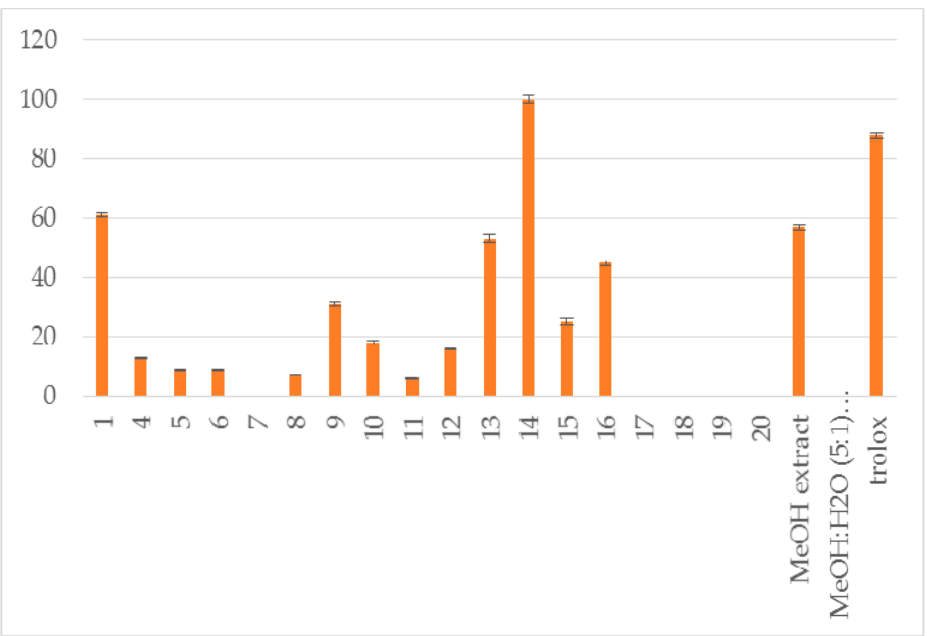
Figure 3. % Inhibition of soybean lipoxygenase (LOX) at 0.1 mM.